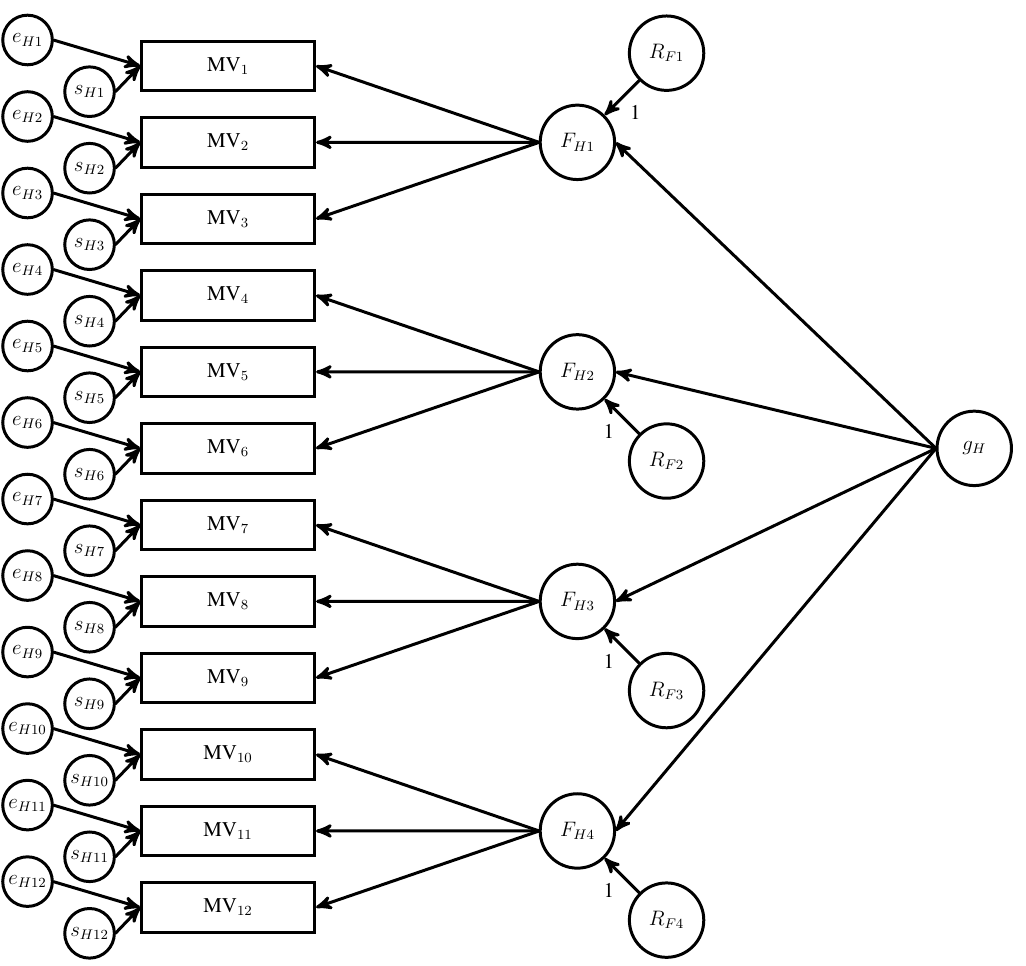
Figure 3. Example of a higher-order factor model. MV: measured variable; F : group factors; s : specific factors; e : error; R : group factor